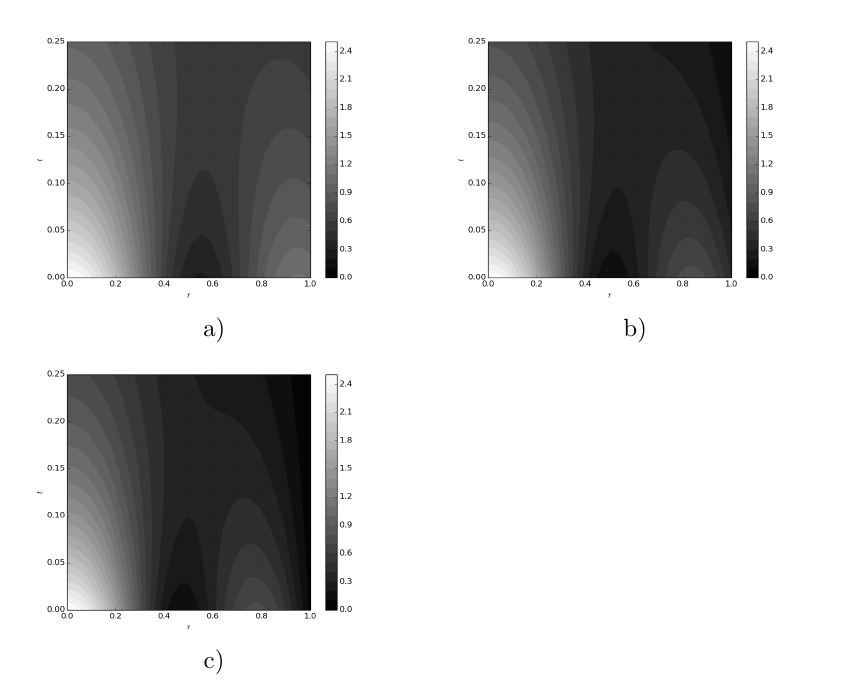
Figure 2. The exact solution for: a) µ = 1, b) µ = 10, c) µ =